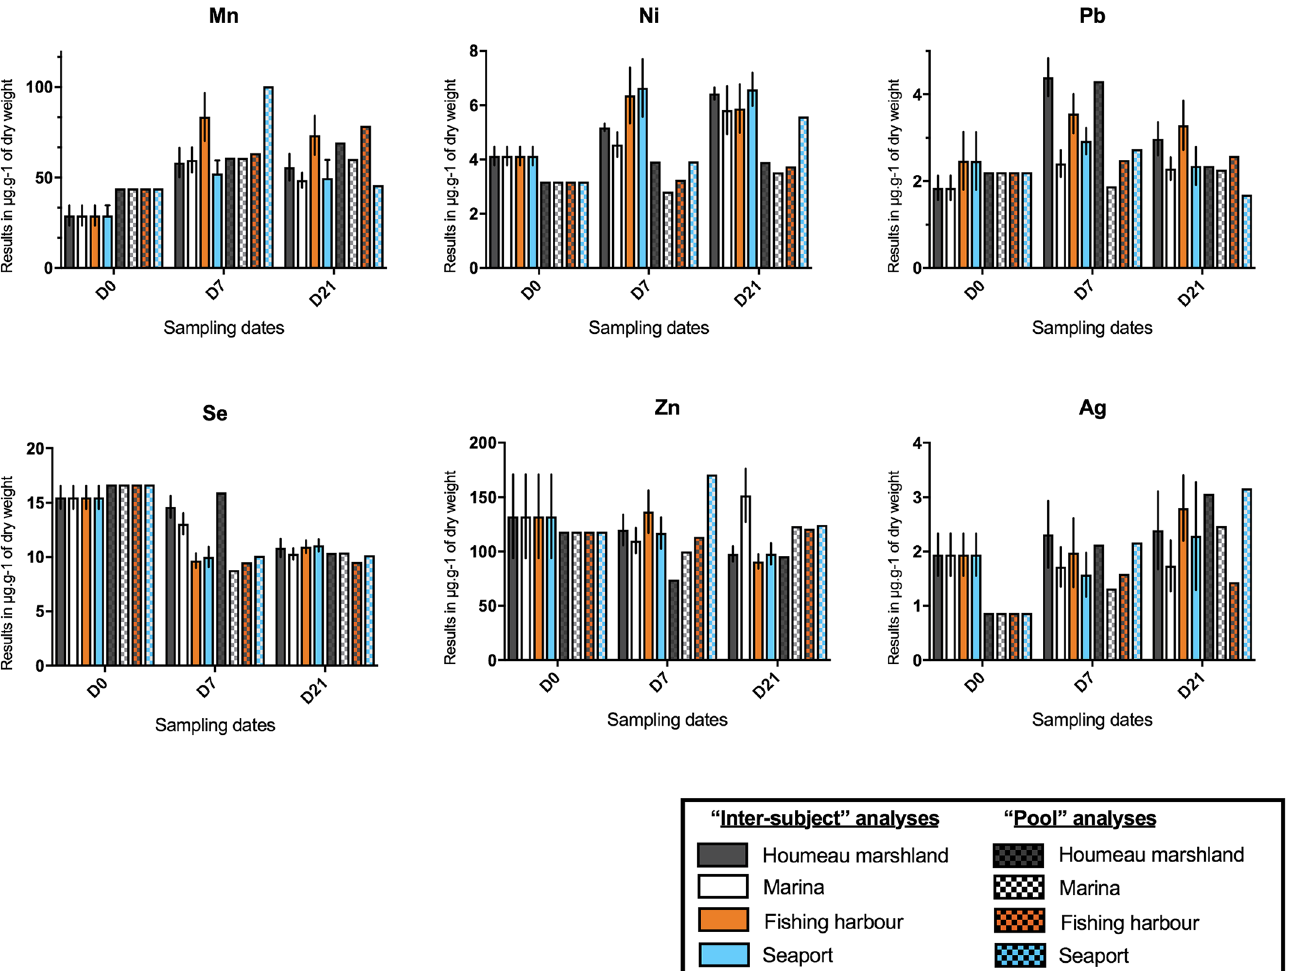
Fig 4. Heavy metals (Mn, Ni, Pb, Se, Zn, Ag) in the digestive glands of black scallops M . varia assessed for all sites (the marshland, the marina, the fishing harbour and the seaport) in 2017 at three sampling dates (D0, D7 and D21). These graphs indicate both “inter-subject” (n = 7/site/sampling) and “pool”